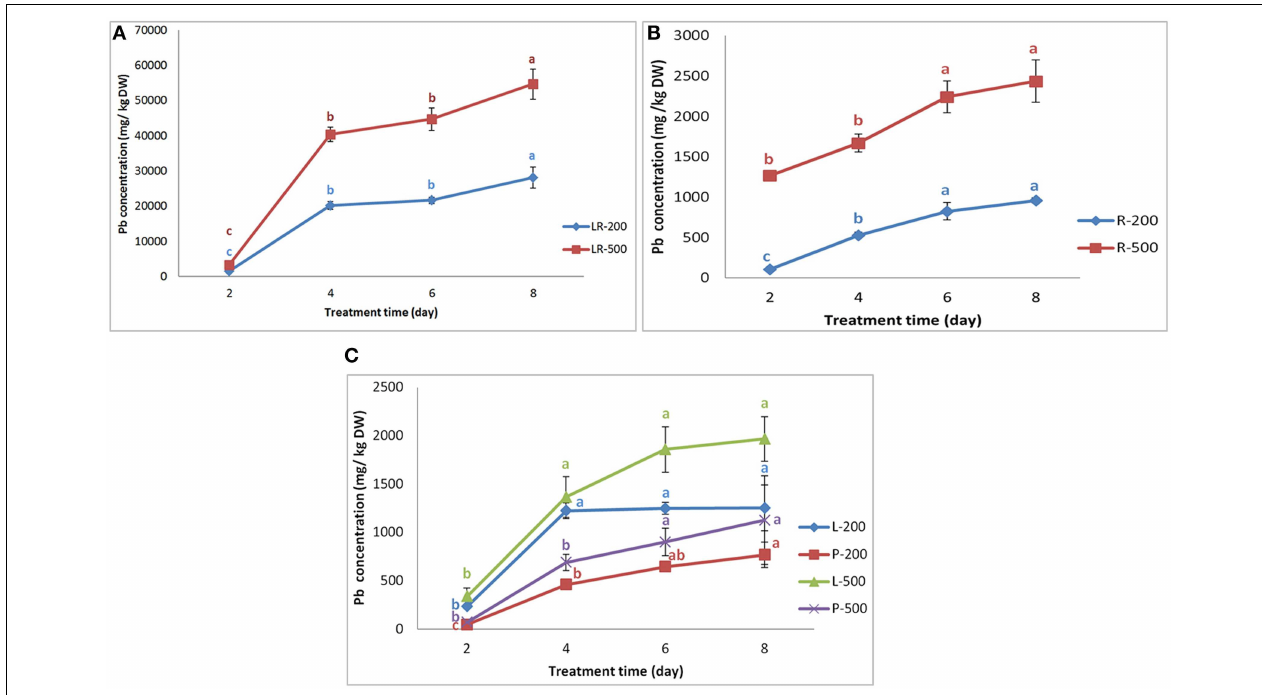
FIGURE 1 | Variation in the Pb concentration in different parts of NAU-XLM. Panels (A,B ) represent the Pb concentration in lateral roots (LR) and roots (R), respectively. LR-200 and R-200 was lateral roots and roots treated with 200 mg/L Pb(NO 3 ) 2 ; while LR-500 and R-500 was lateral roots and roots treated with 500 mg/L Pb(NO 3 ) 2 . Panel (C)